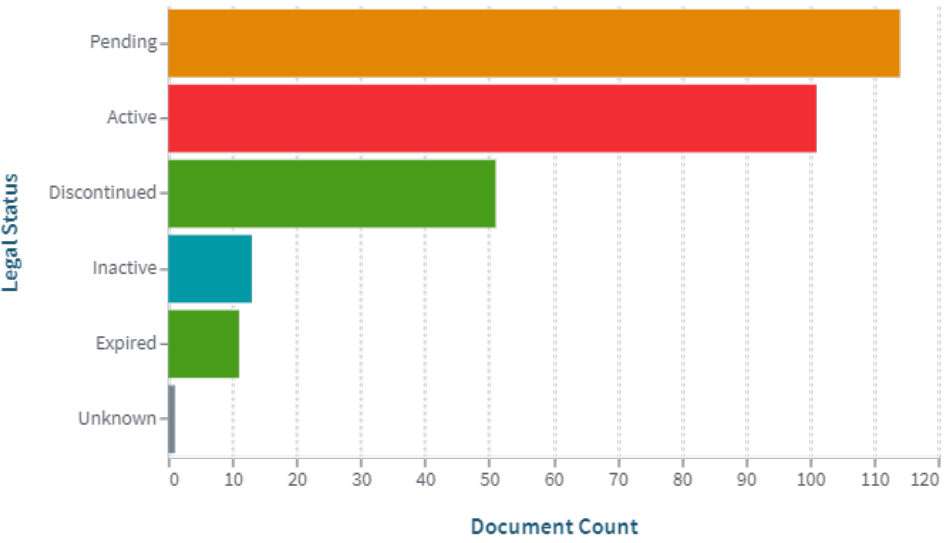
Figure 1. Dynamics of patent activity by applicants in the field of digital pills with ingestible sensor (https://www.lens.org, accessed on 30 July 2022).